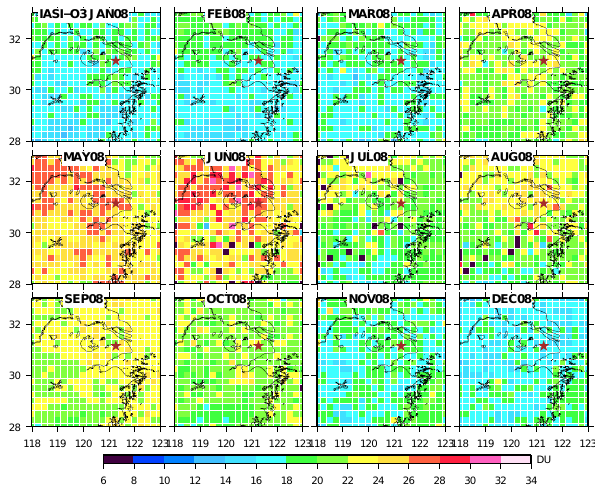
Fig. 10. Same as Fig. 8 for